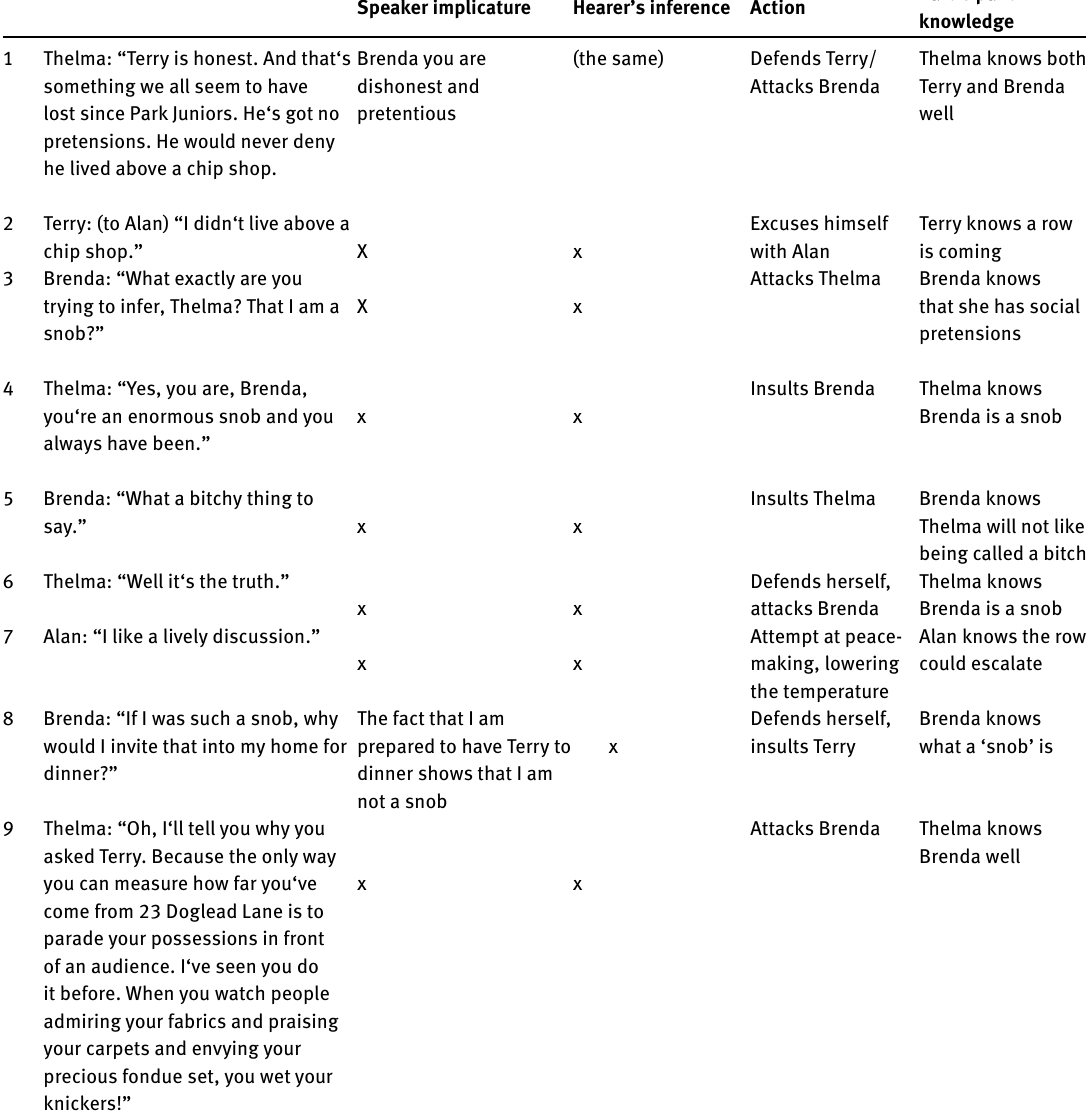
Table 5: ‘Guess who’s coming to dinner’, extract 5 Speaker implicature Hearer’s inference Action